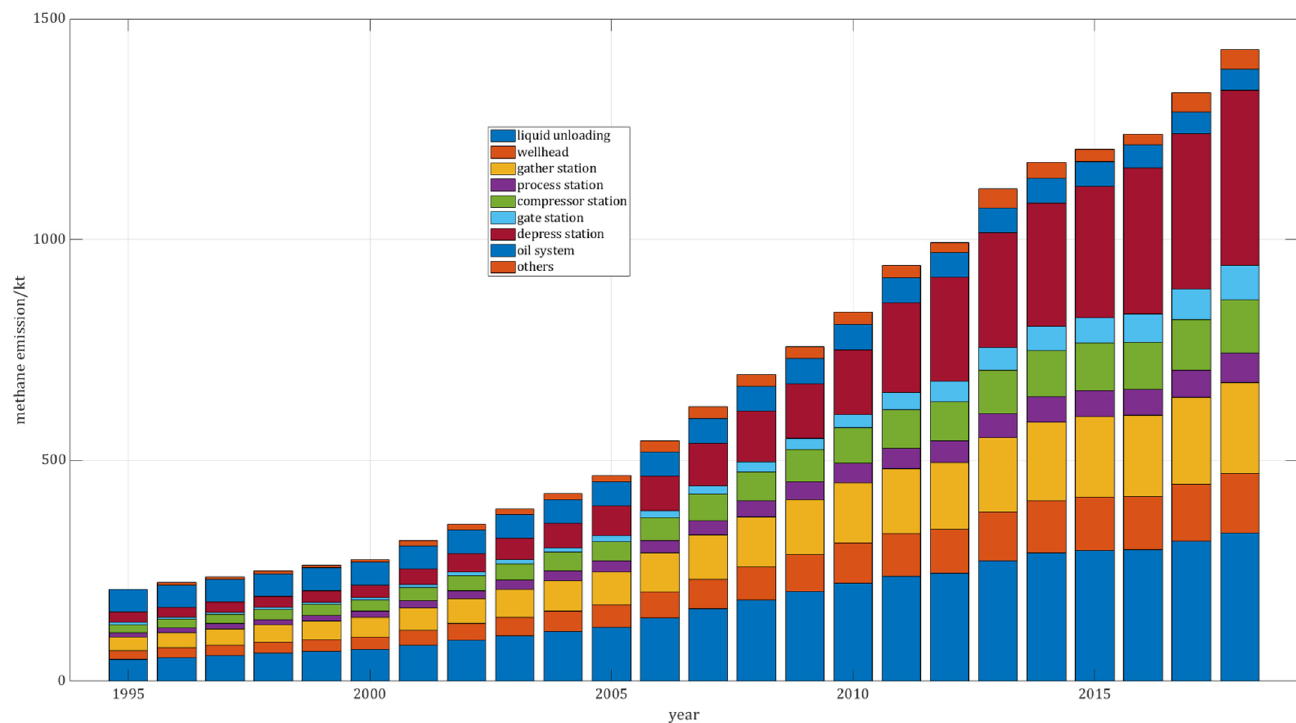
Figure 5. Methane emission from different sources.